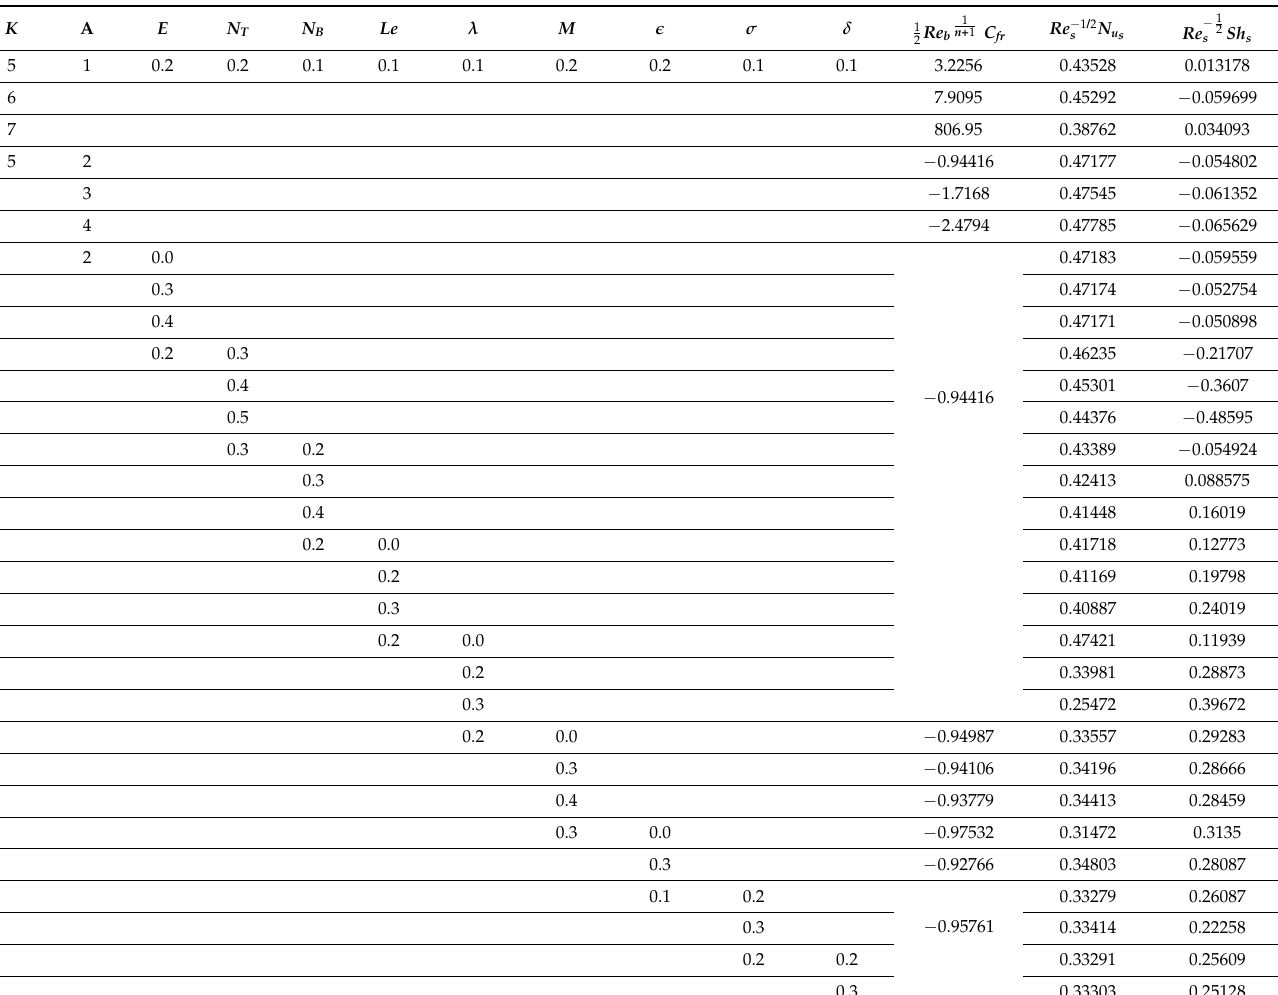
− 1 2 s Sh s ) for n = and Re s